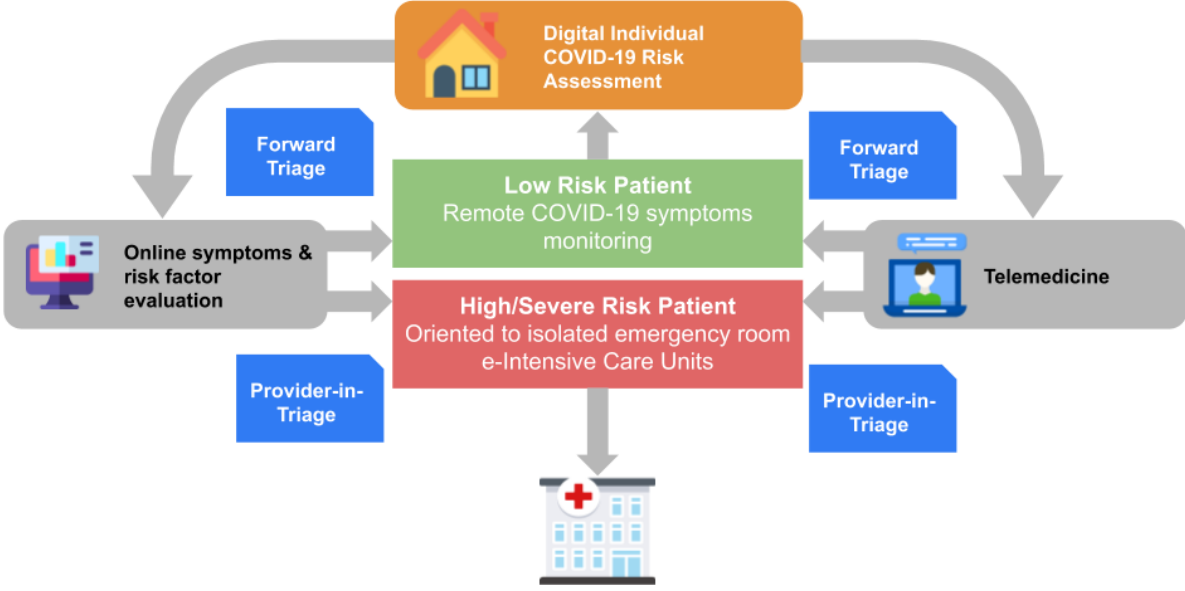
Figure 2. Risk assessment and triage of COVID-19 in a digital health care model. COVID-19: coronavirus disease.